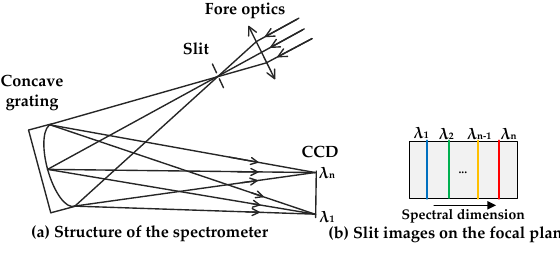
Figure 1. Schematic of a typical concave grating spectrometer